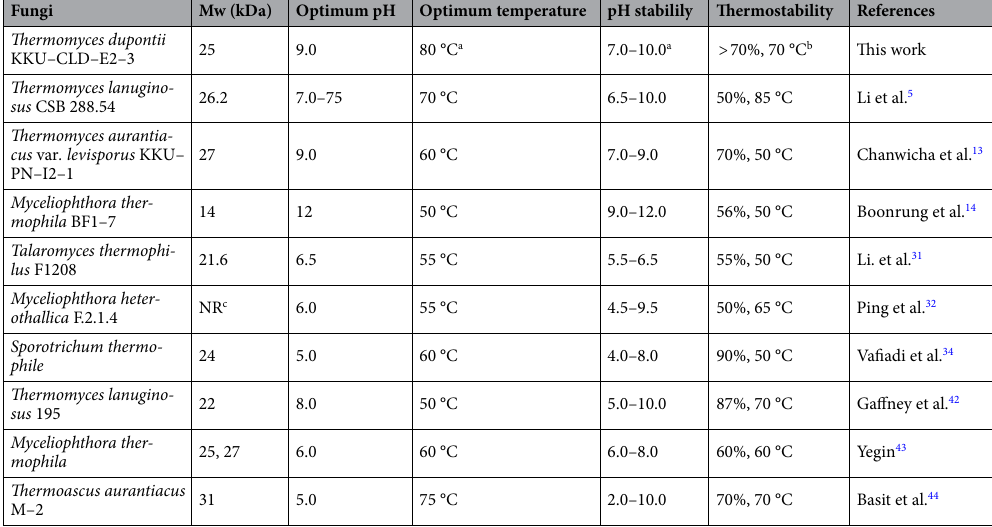
Table 4. Some enzymatic properties of purified xylanase from xylanase-producing thermophilic fungi. a Pre-